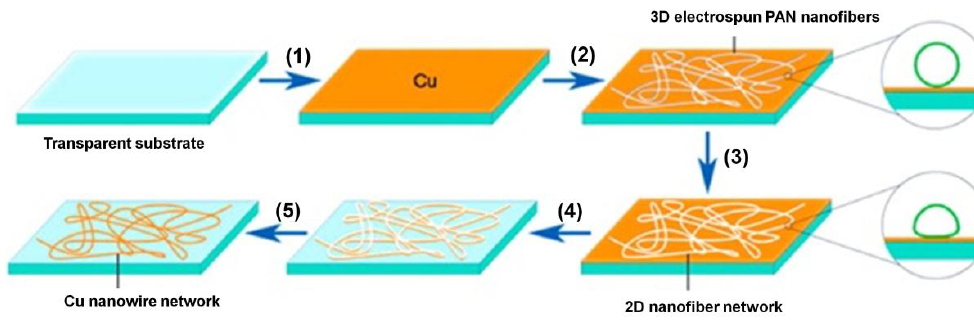
Figure 4. Scheme of Cu NW network electrode fabrication: ( 1 ) Electron-beam deposition of Cu film on the transparent substrate; ( 2 ) Electrospun polyacrylonitrile (PAN) nanofibers on the Cu-covered substrate; ( 3 ) Solvent vapor annealing. The insets show schematics of the fiber cross-sections before and after solvent vapor annealing; ( 4 ) Metal etching; ( 5 ) Removal of PAN fibers by dissolution. Cu NW network on transparent substrate after PAN is removed (Reproduced with permission from [73]. Copyright American Chemical Society,